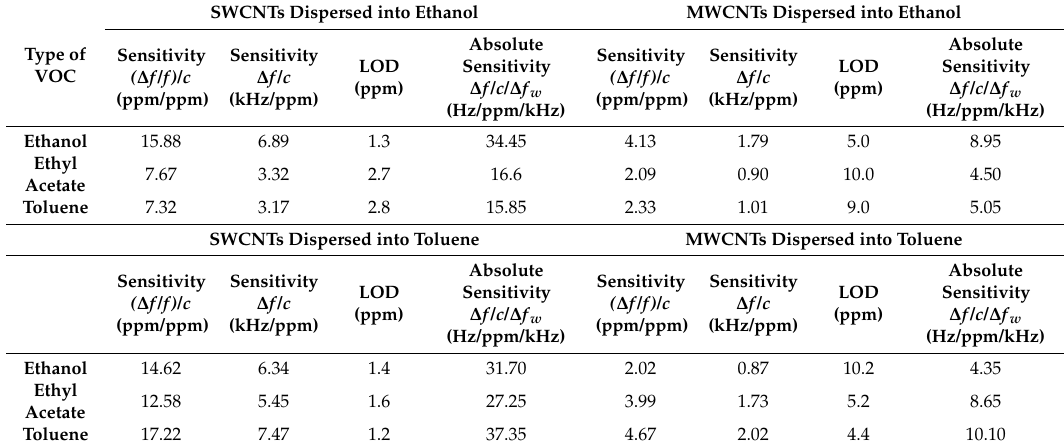
Table 2. Comparison of sensor responses of 433.92 MHz SAW coated with SWCNTs and MWCNTs dispersed separately in ethanol and toluene. Adapted with permission from [97], copyright (2005)